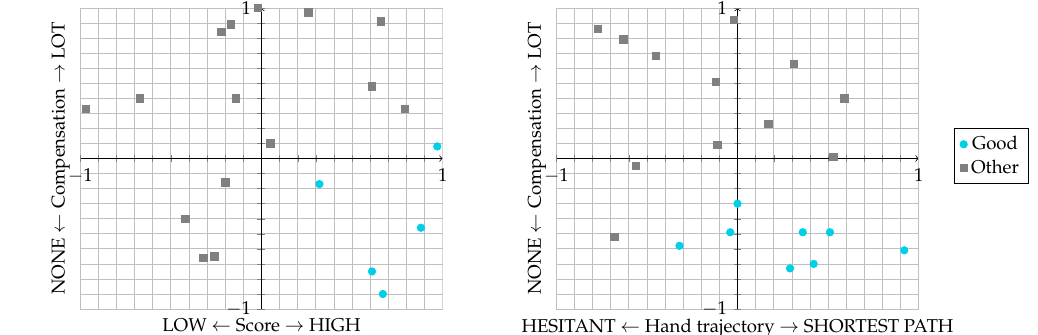
Figure 5. Plot of Score–Compensation and Hand trajectory–Compensation features in ShelfCans game. Data were labelled as “Good” or “Other” by the therapist according to patients’ performance.